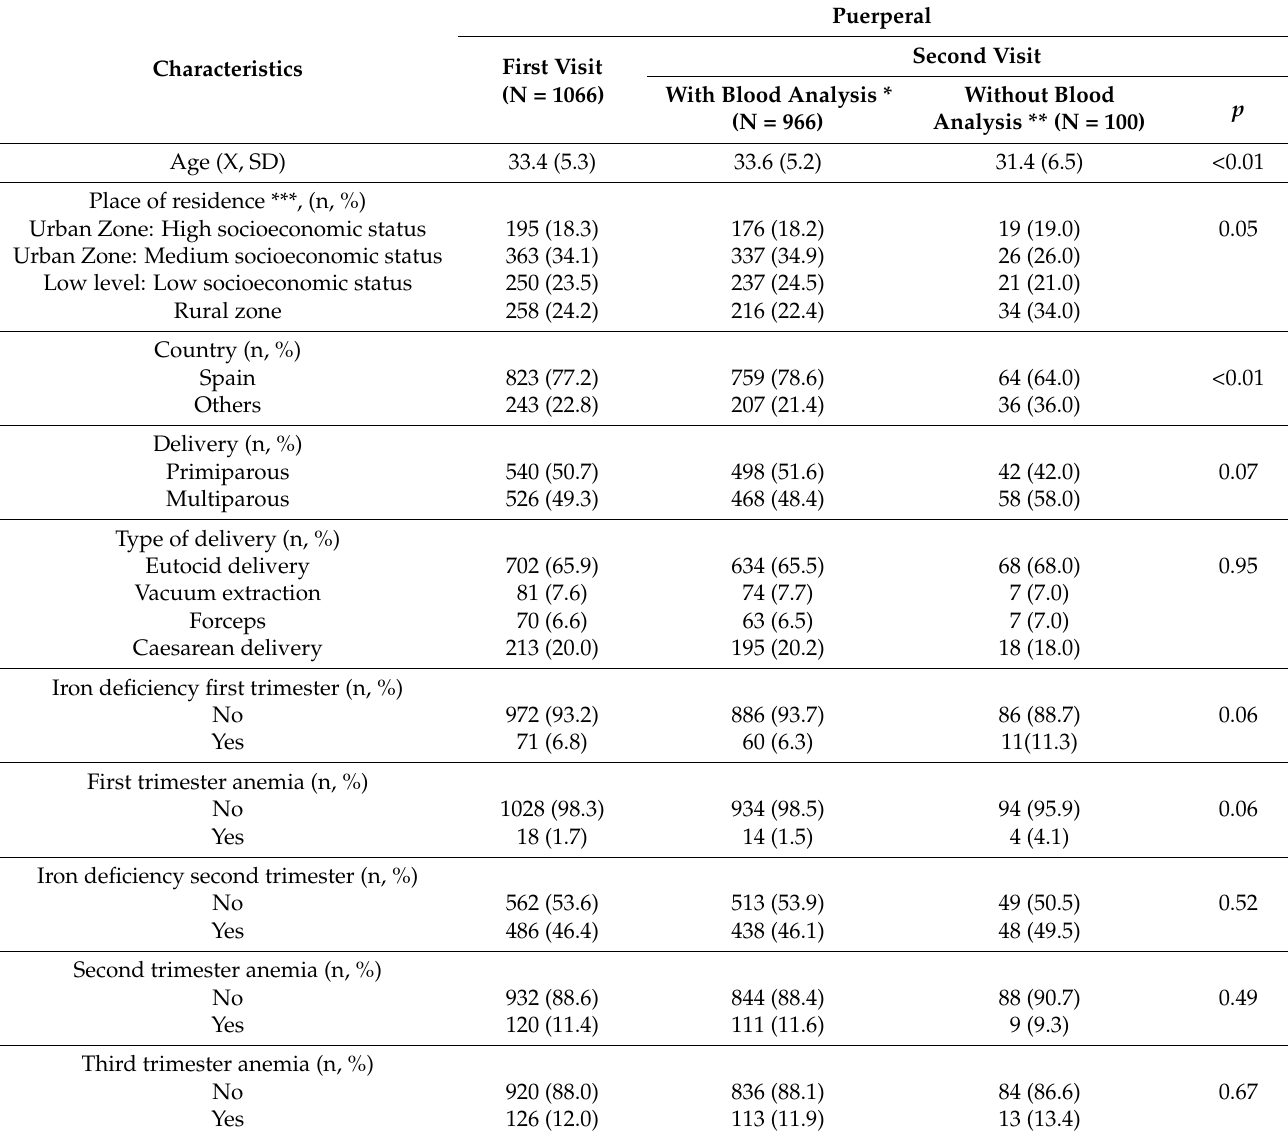
Table 1. Sociodemographic characteristics of the cohort of women in the postpartum period (from the first to the sixth week